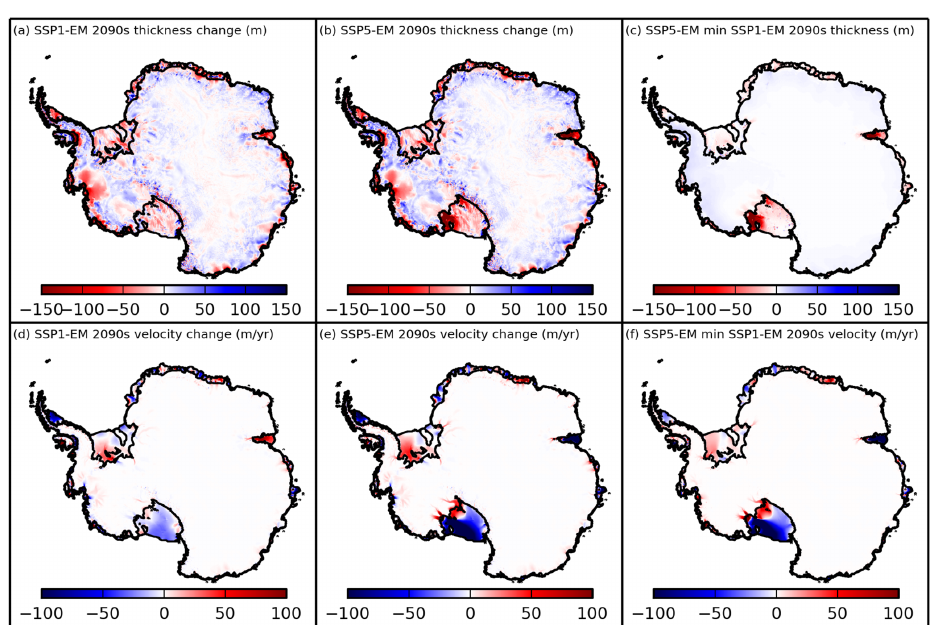
Figure 15. Change in (a–c) ice thickness and (e–f) surface velocity magnitude between (a,d) 2015 and 2100 for SSP1–1.9 and (b,e) 2015 and 2100 for SSP5–8.5. (c,f) Difference in (c) ice thickness and (f) surface velocity magnitude in the final period between SSP5–8.5 and